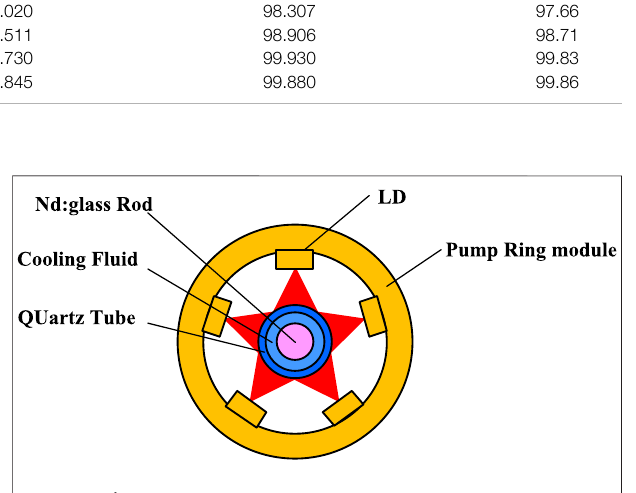
FIGURE 4 | Pro fi le of the laser ampli fi